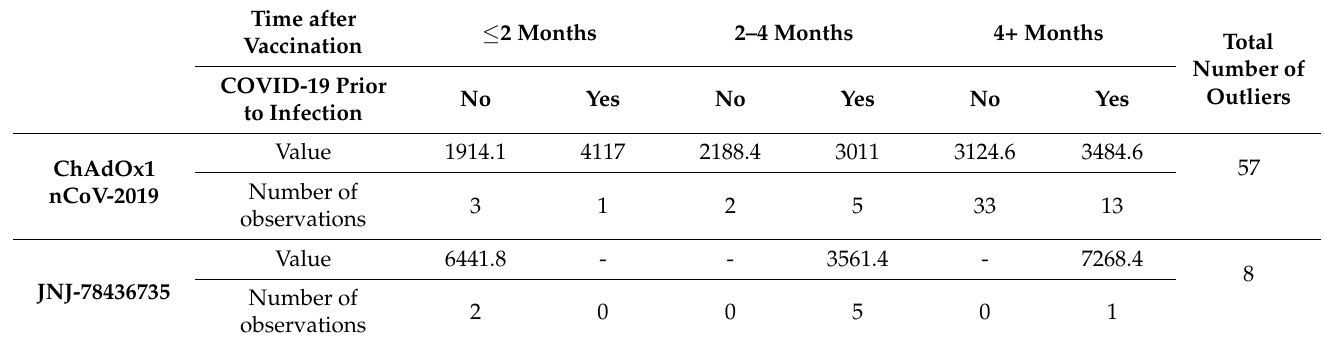
Table 3. Minimal values and the numbers of outliers for each group determined by the time after